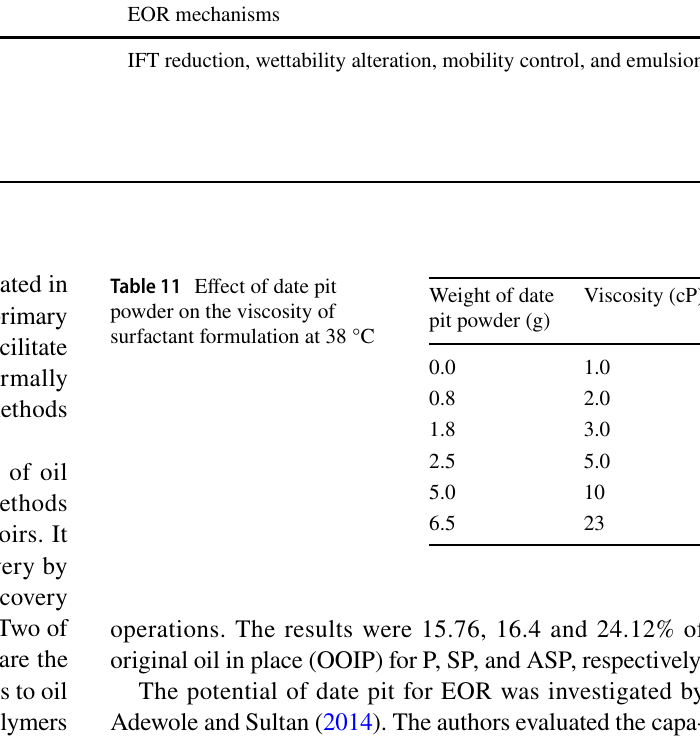
tensionDetailed methods